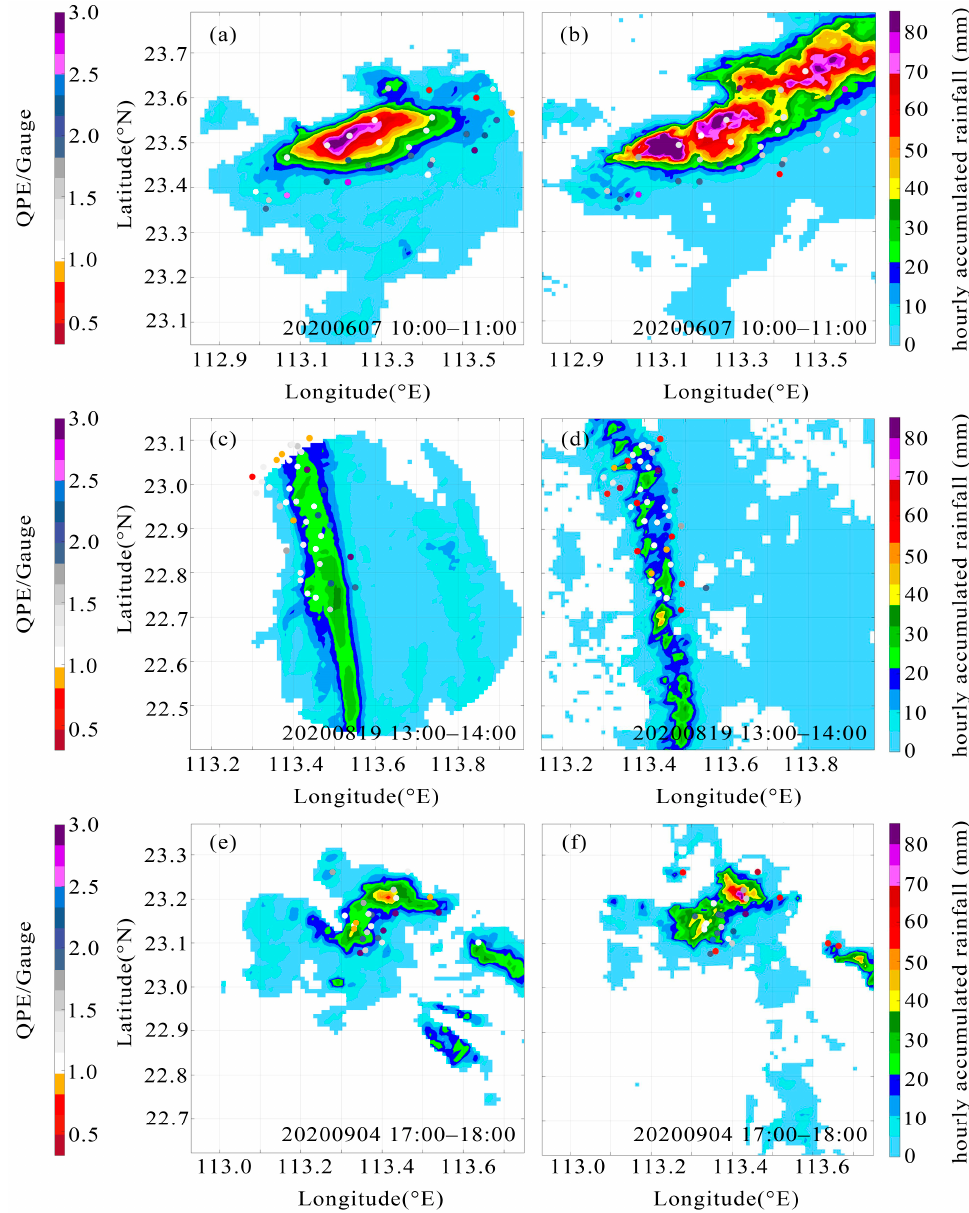
Figure 9. Comparison of hourly accumulated rainfall obtained using R ( K DP ) with gauge observa- tions in the pre-summer rainfall between 10:00–11:00 on June 7, the typhoon precipitation between 13:00–14:00 on August 19, and the severe convective precipitation rainband between 17:00–18:00 on September 4. ( a , c , e ) for X-band band radar and ( b , d , f ) for S-band band radar. The color of the bubble charts shows bias ratios ( R K / R gauge ) between the hourly accumulated rainfall estimates and independent gauge